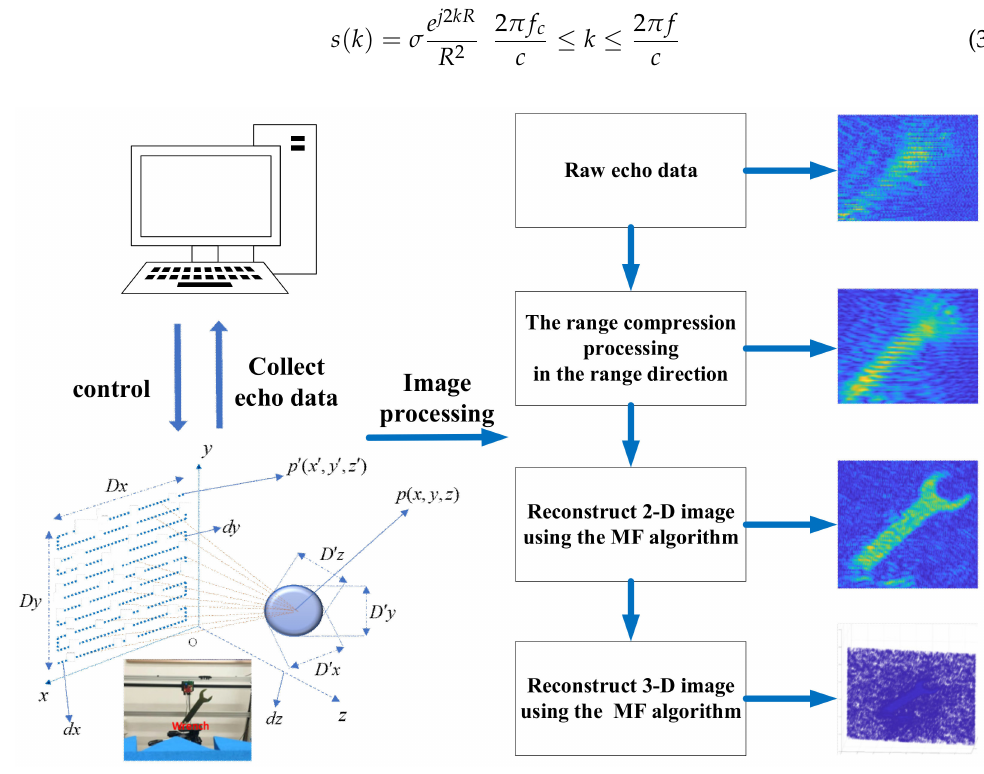
Figure 1. The mmWave SAR imaging